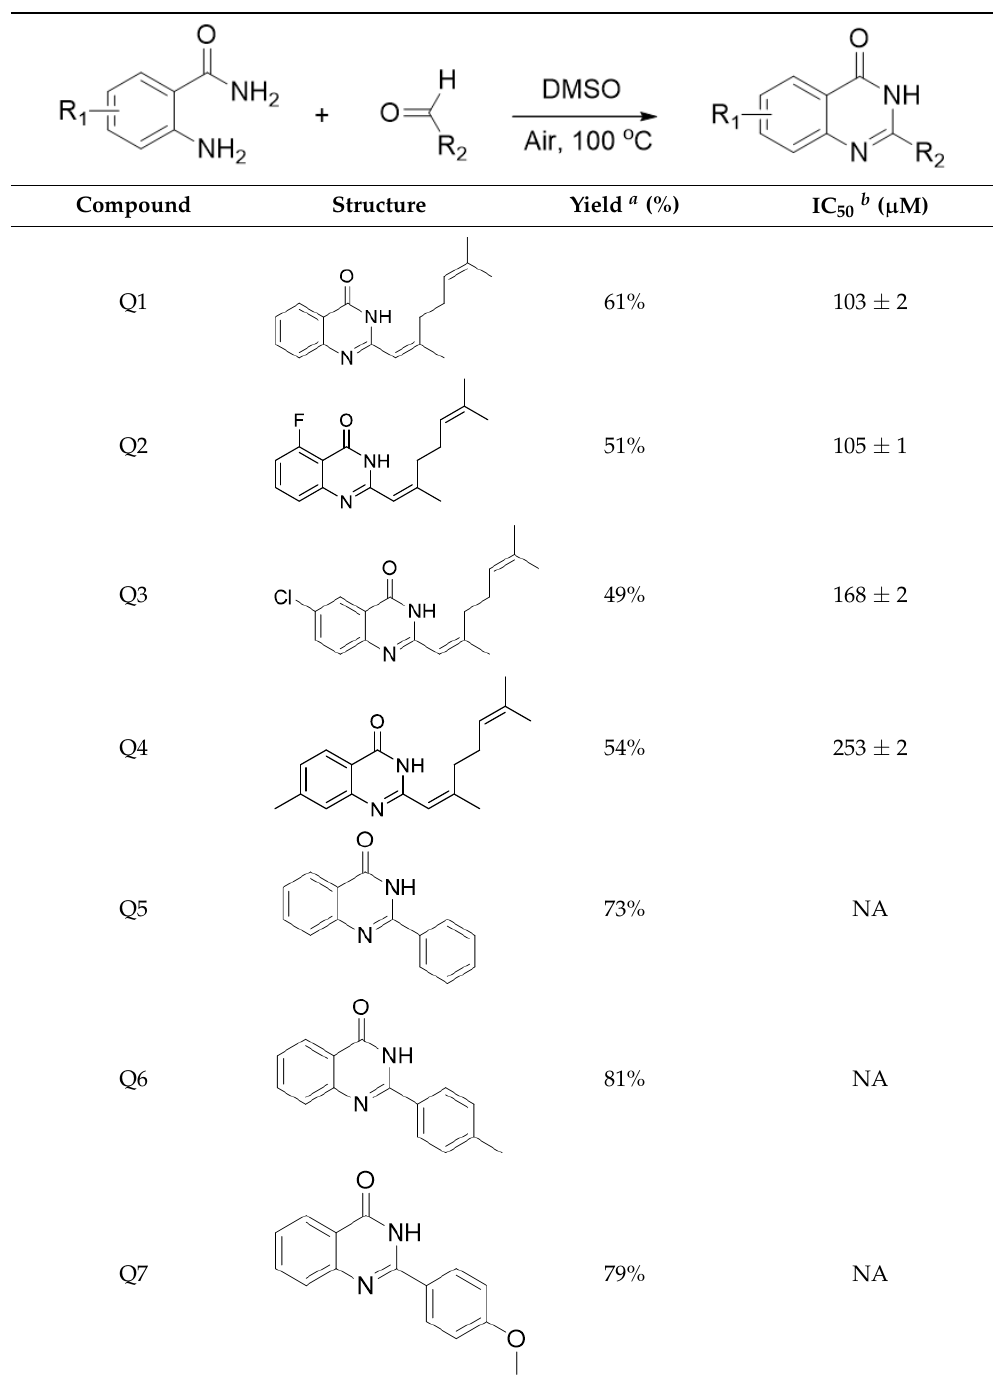
Table 1. Synthesis and inhibition of quinazolinone derivatives on tyrosinase.